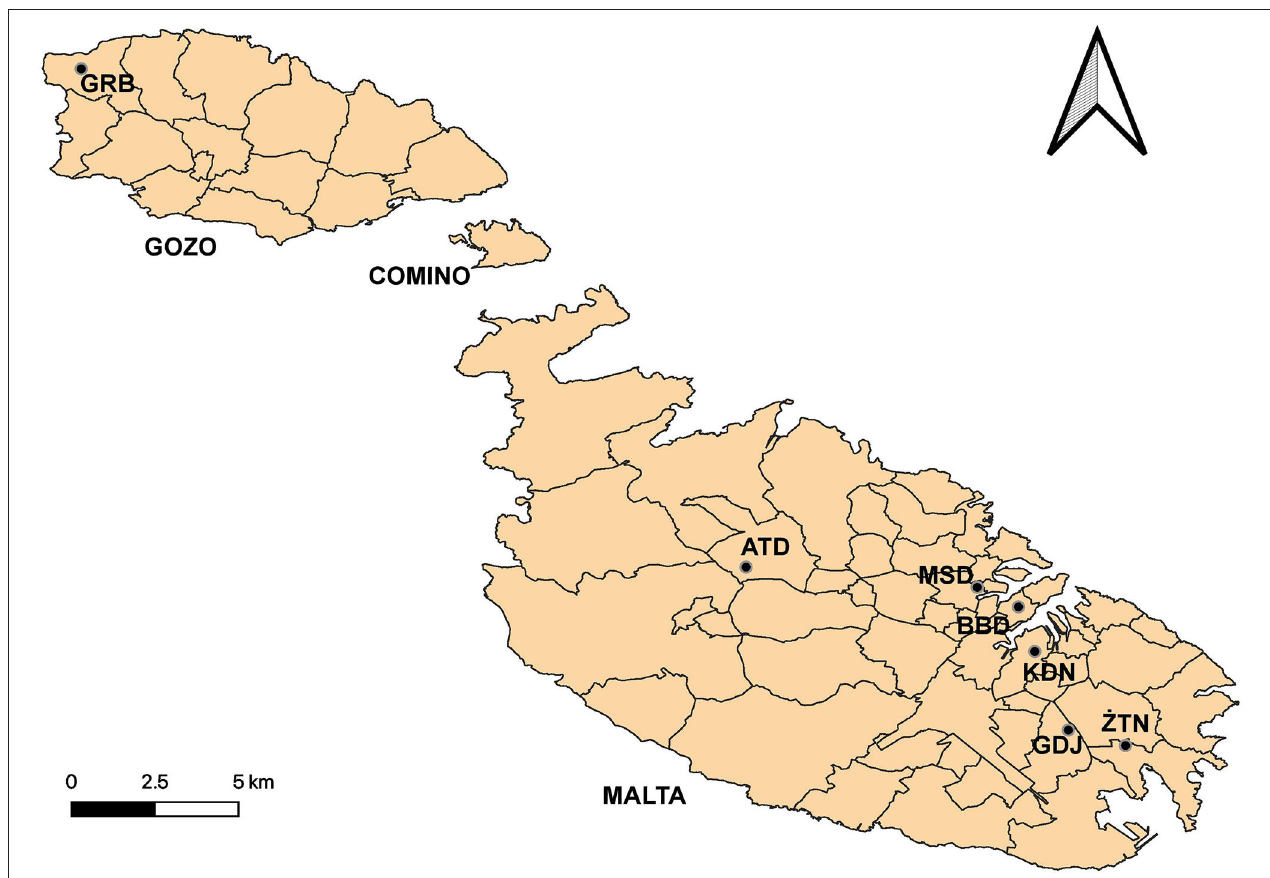
FIGURE 1 | Air quality monitoring stations in Malta: Attard (ATD), Msida (MSD), Kordin (KDN) and ˙ Zejtun (ZTN) and in Gozo: G è arb (GRB). Traffic count sensors in Blata L-Bajda (BBD) and Gudja